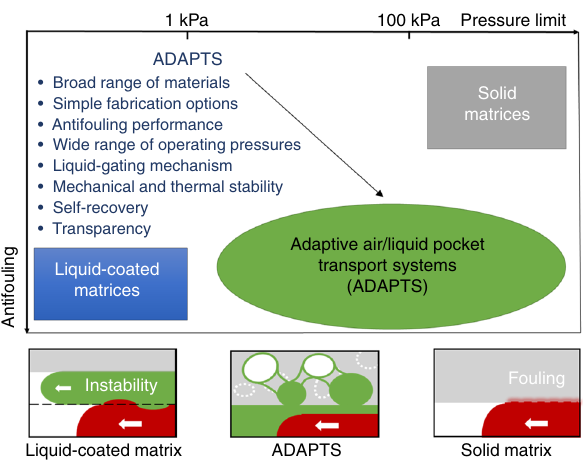
Fig. 5 Qualitative comparison in terms of antifouling and operating pressure. Schematics illustrate the surface fouling and instability associated with the solid matrix and liquid-coated matrix,